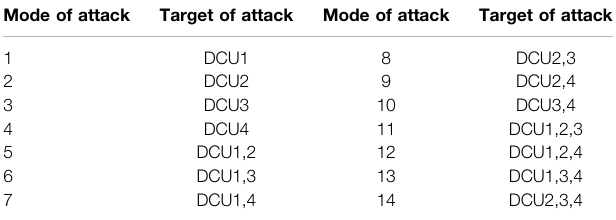
TABLE 1 | Price tampering attack methods. Mode of